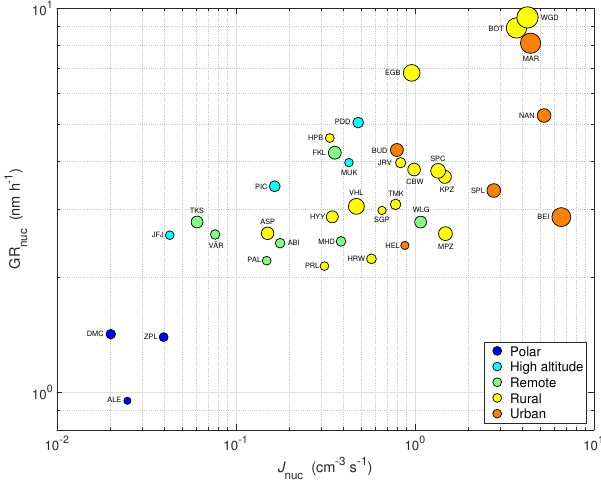
Figure 6. Annual-median, site-specific particle formation rate as a function of the corresponding growth rate. The marker size is pro- portional to the annual-median NPF frequency and the marker col- ors show the environment types of the